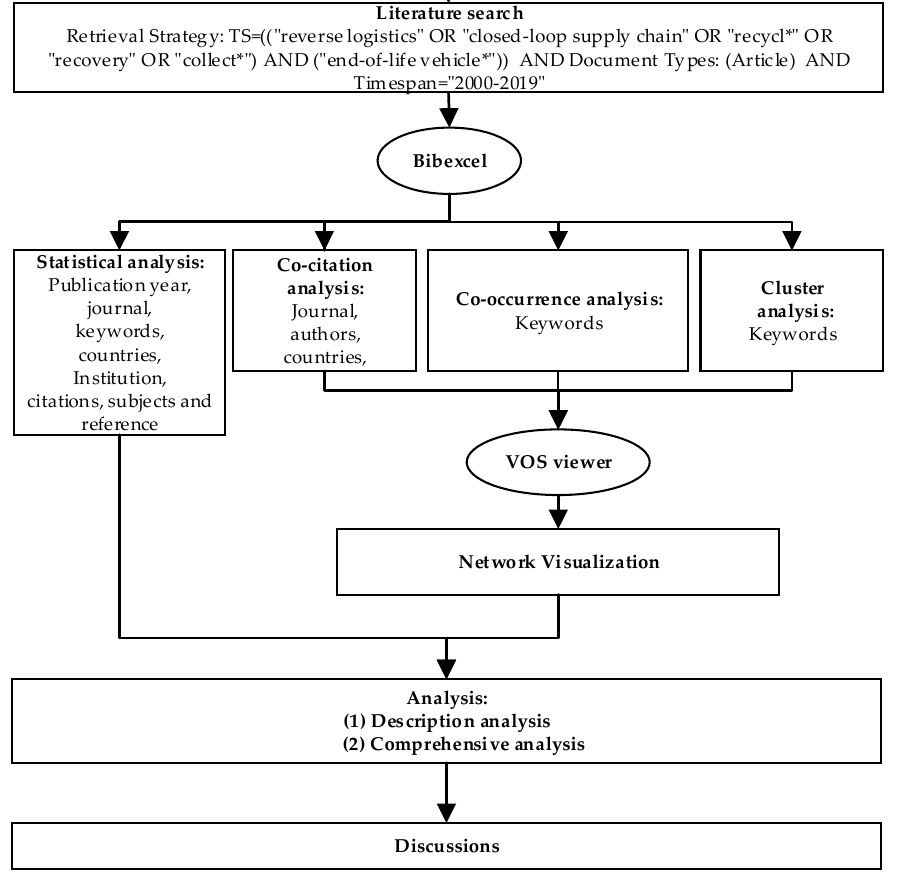
Figure 3. The general flow diagram for systematic bibliometric analysis.